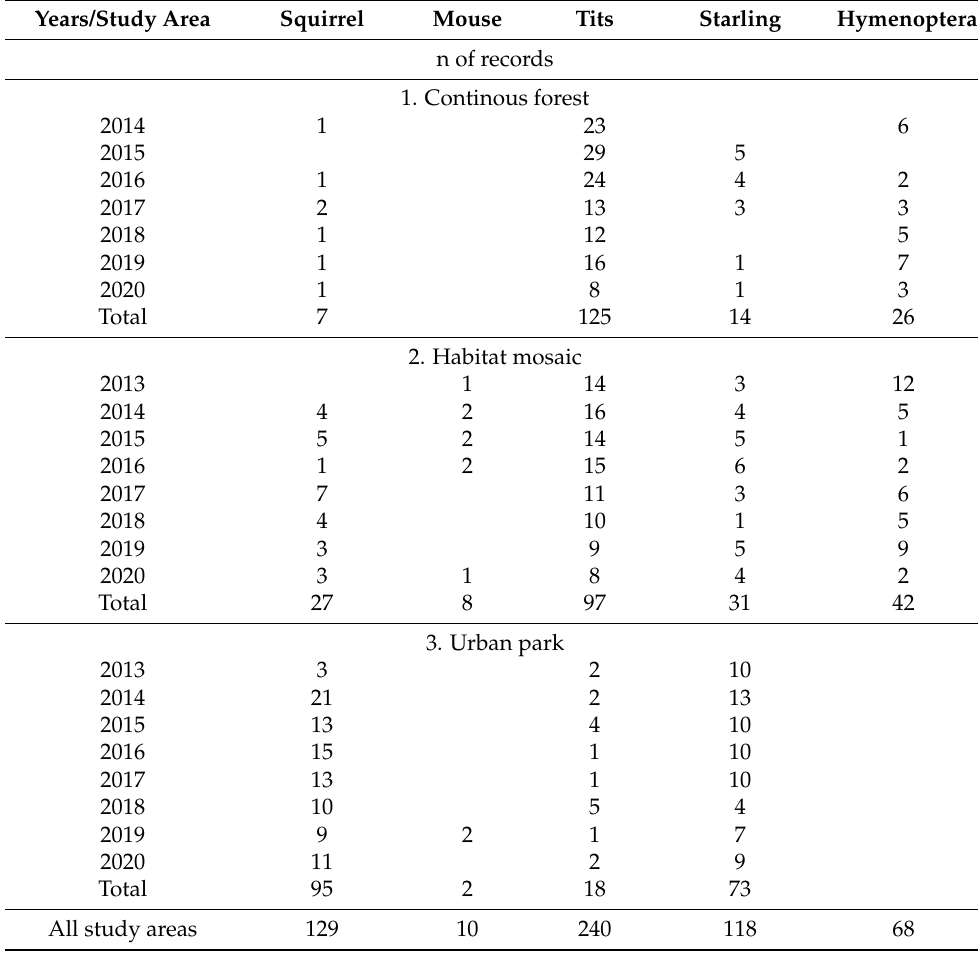
Table A1. The number of records of presence of a species/higher taxa (red squirrel, yellow-necked mouse, tits, European starling, Hymenoptera) in the nest boxes dedicated to the red squirrels in the three habitats of different level of anthropopression in central